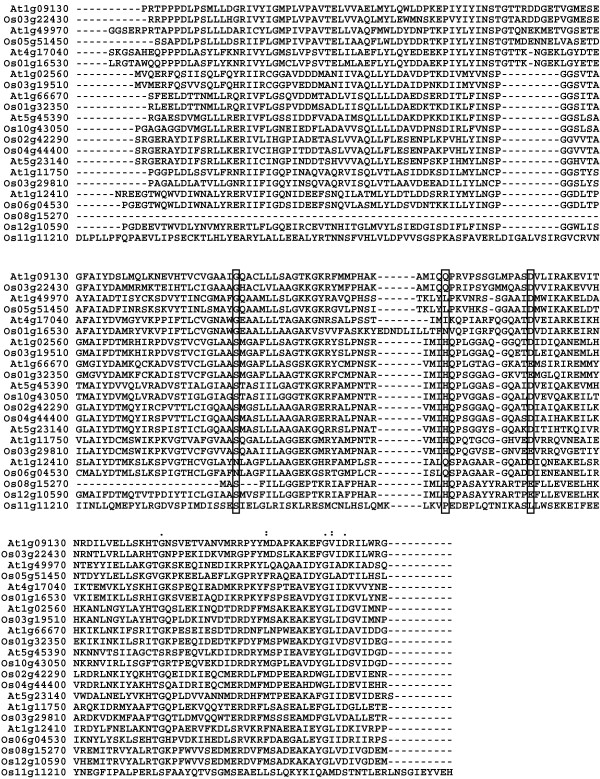
Multiple sequence alignment of the Clp protease domain region of the annotated Arabidopsis and rice Clp protease-like proteins. The catalytic triad residues are indicated. Gene names correspond to those in Additional files 1 and 2. For brevity, rice gene names have been shortened to OsXXg##### instead of LOC_OsXXg#####, XX referring to chromosome 1–12 and a 5 digit number assigned to each gene. Several gene products that display mutation in one or more catalytic triad residues can be visualised here (see text for details).